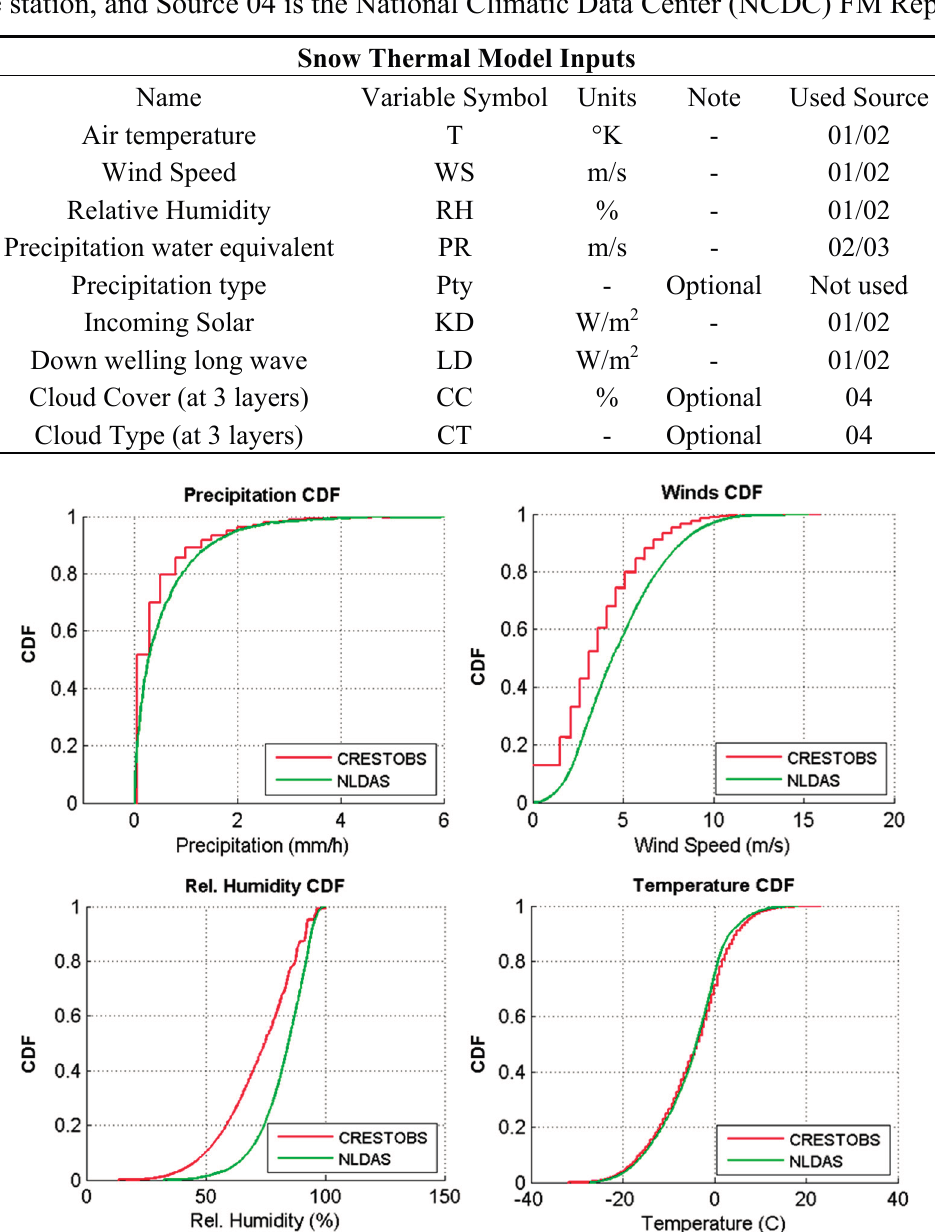
Figure 2. Meteorological data cumulative distribution function (CDF) of observed meteorological data (CRESTOBS) and assimilated meteorological data from the National Land Data Assimilation System (NLDAS). Variables in figures: precipitation ( upper left ); Winds ( upper right ); relative humidity ( lower left ); and temperature ( lower right